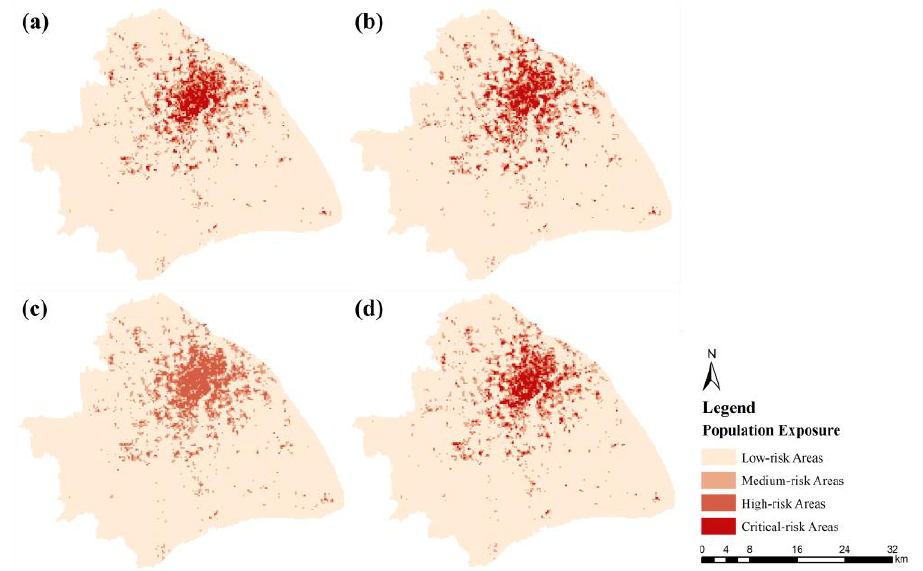
Figure 5. Spatial distribution of NO 2 exposure during ( a ) daytime (9 a.m. – 5 p.m.), ( b ) nighttime (7 p.m. – 7 a.m.), ( c ) morning peak (7 a.m. – 9 a.m.), and ( d ) evening peak (5 p.m. – 7 p.m.) in Shanghai.